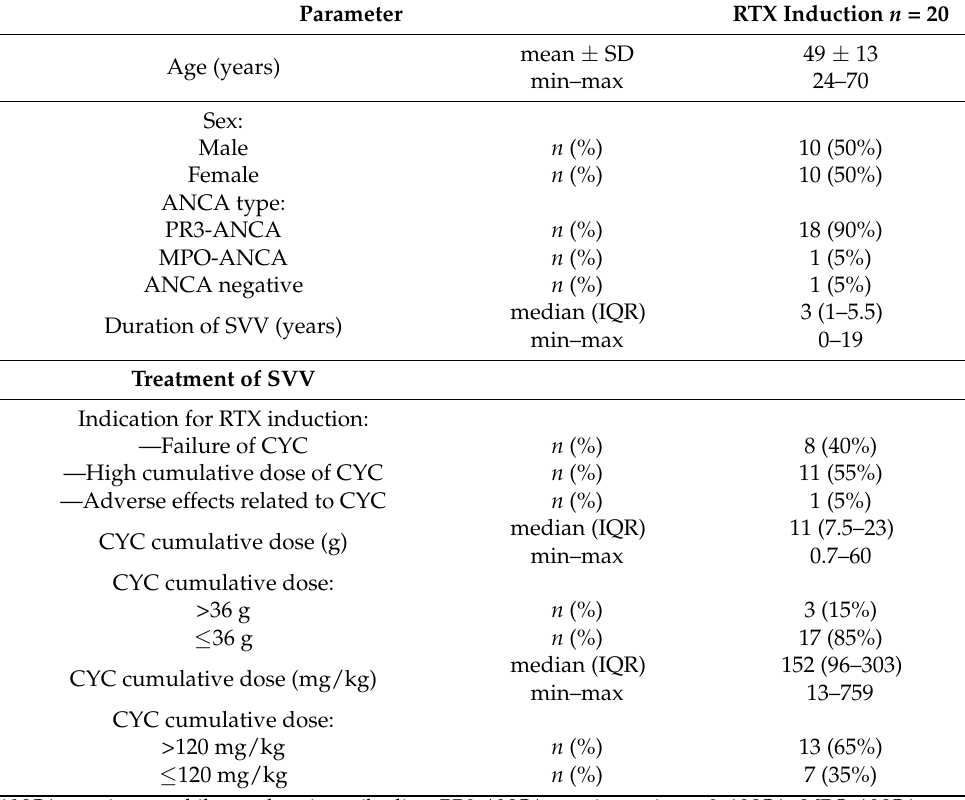
Table 1. Baseline characteristics of the study population (part 1).